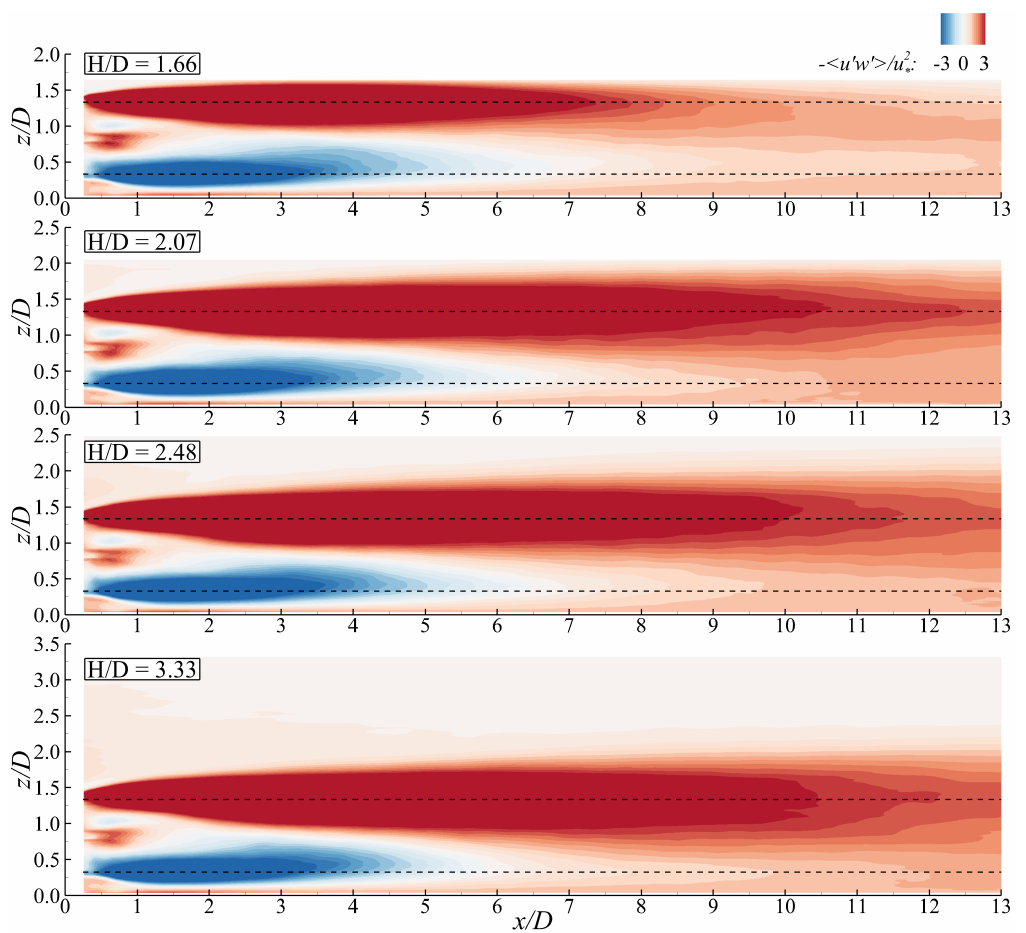
Fig. 4. Distribution of vertical shear stresses normalised by friction velocity (– ⟨ u ′ w ′ ⟩ /u 2 ∗ ) over the xz vertical plane for the four submergence cases. Results are averaged over the lateral wake region, as indicated in Figure 1.